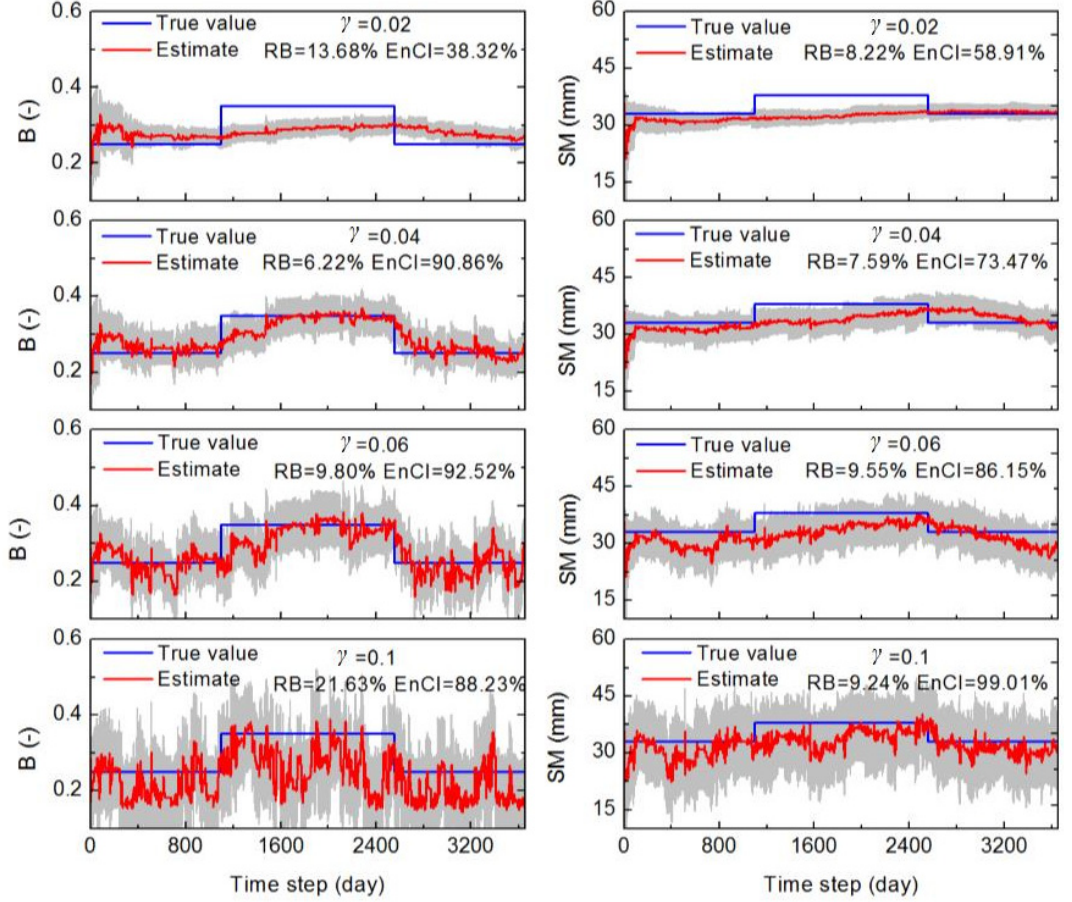
Figure 6. Tracing parameter changes under different values of γ for the case of the rotational change.